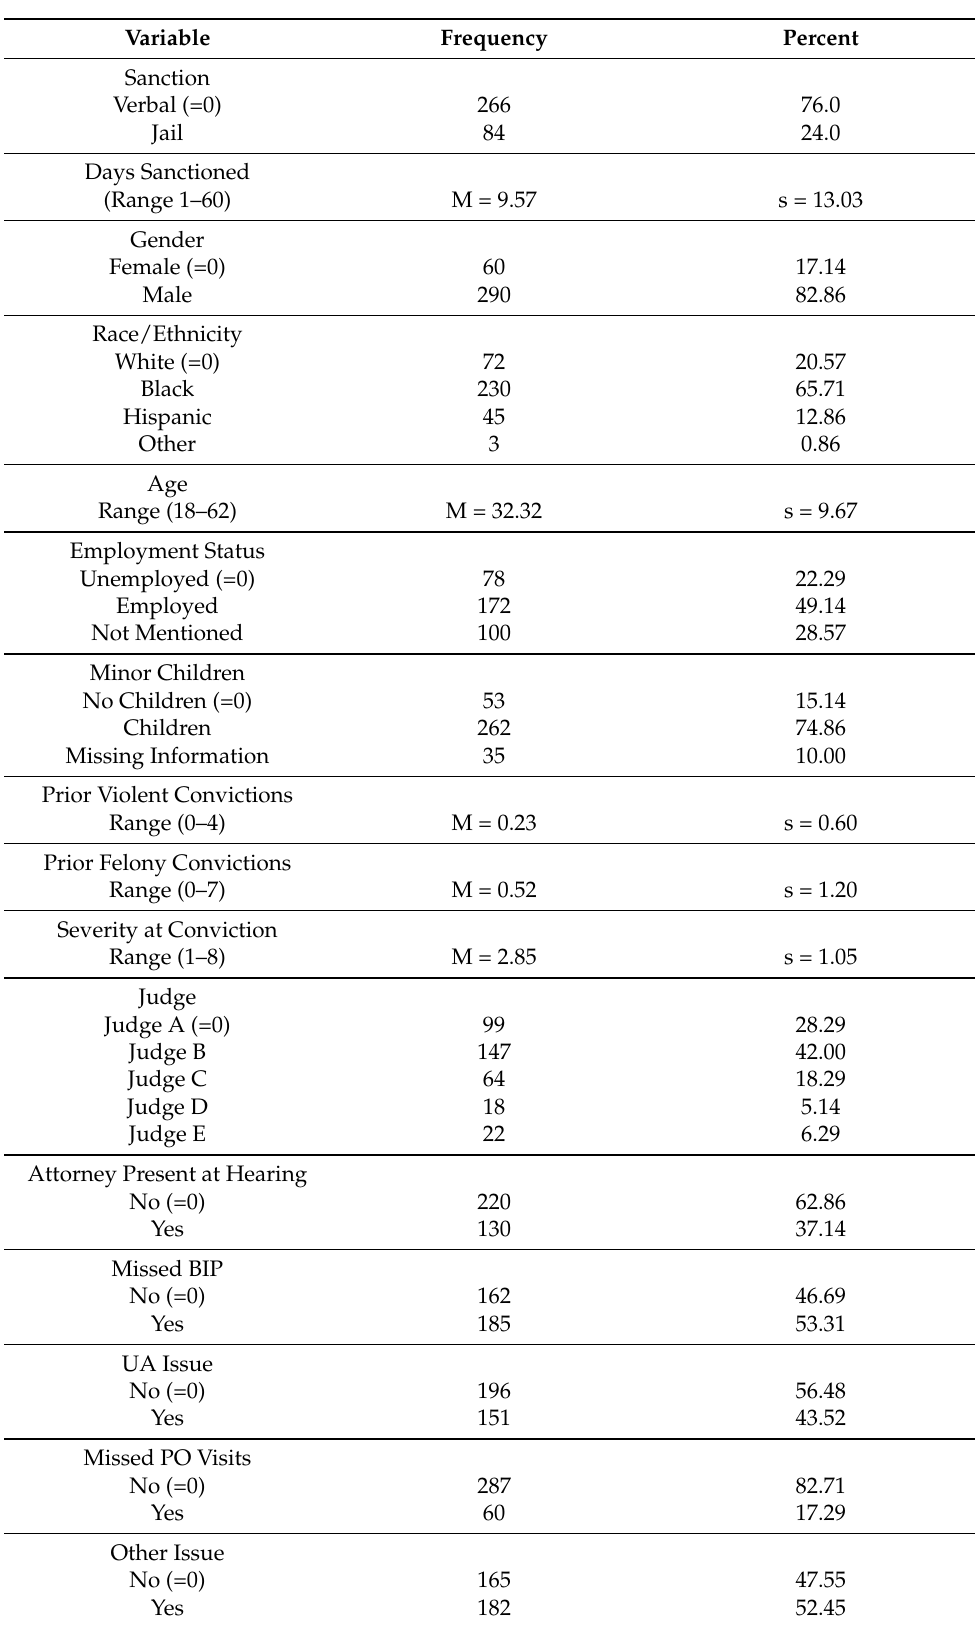
Table 1. Descriptive Statistics on Dependent, Independent, and Control Variables ( n = 350)